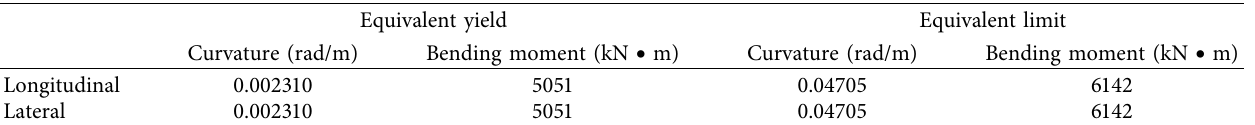
Table 4: Equivalent bifurcation moment-curvature relationship of bridge pier